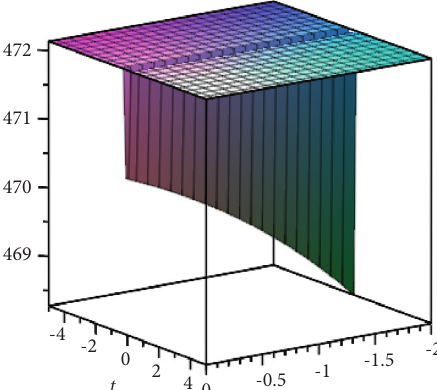
Figure 1: The dark soliton solution of | q � 0 . 2 , f � − 2 . 5, a � − 2 , within theinterval − 4 ≤ x c � − 1 , k � 3 , a 1 ≤ 0 , − 5 ≤ t ≤ 5.